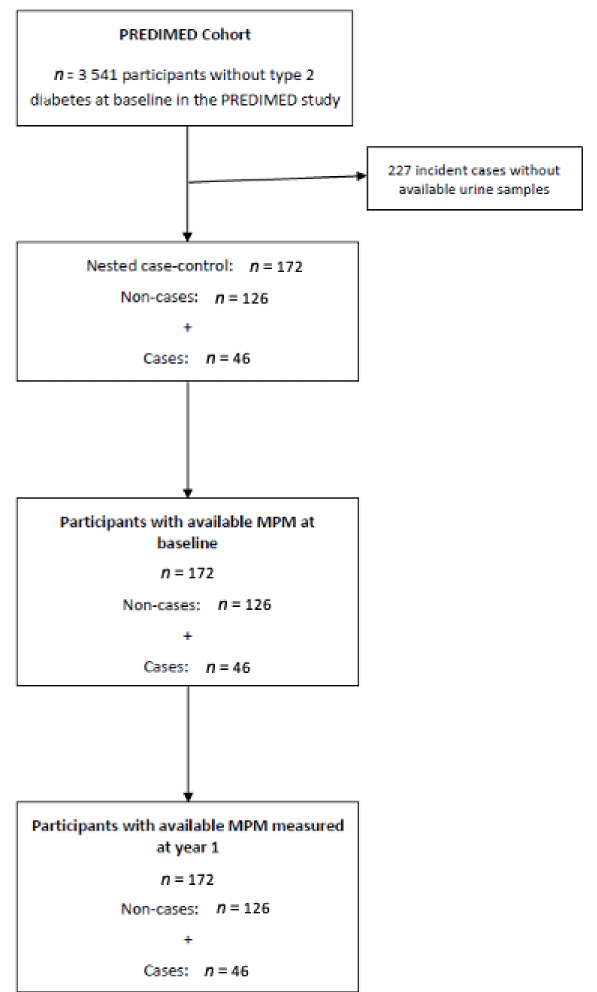
Figure 1. Flow-chart of the case-control